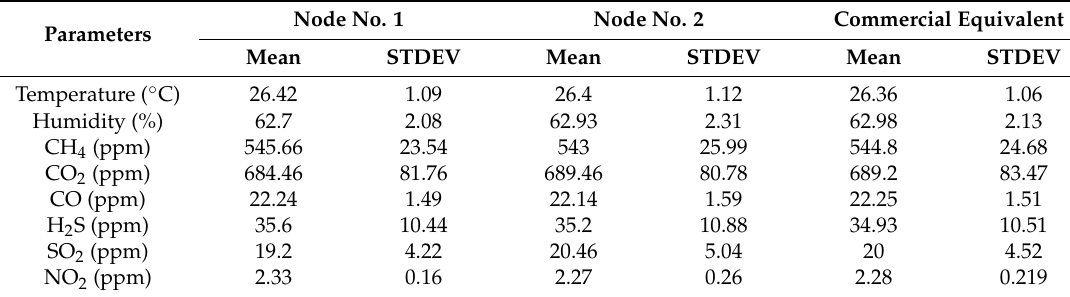
Table 5. Mean and standard deviations of nodes for gas module